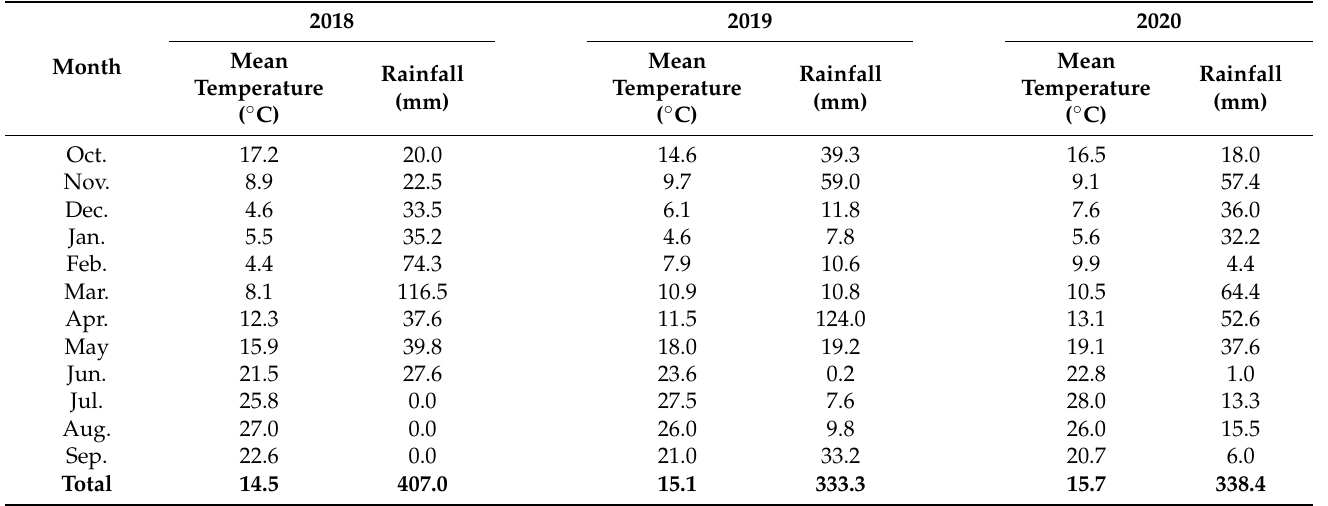
Table 2. Total rainfall and monthly mean temperature at the experimental site during the 2018, 2019, and 2020 agronomic